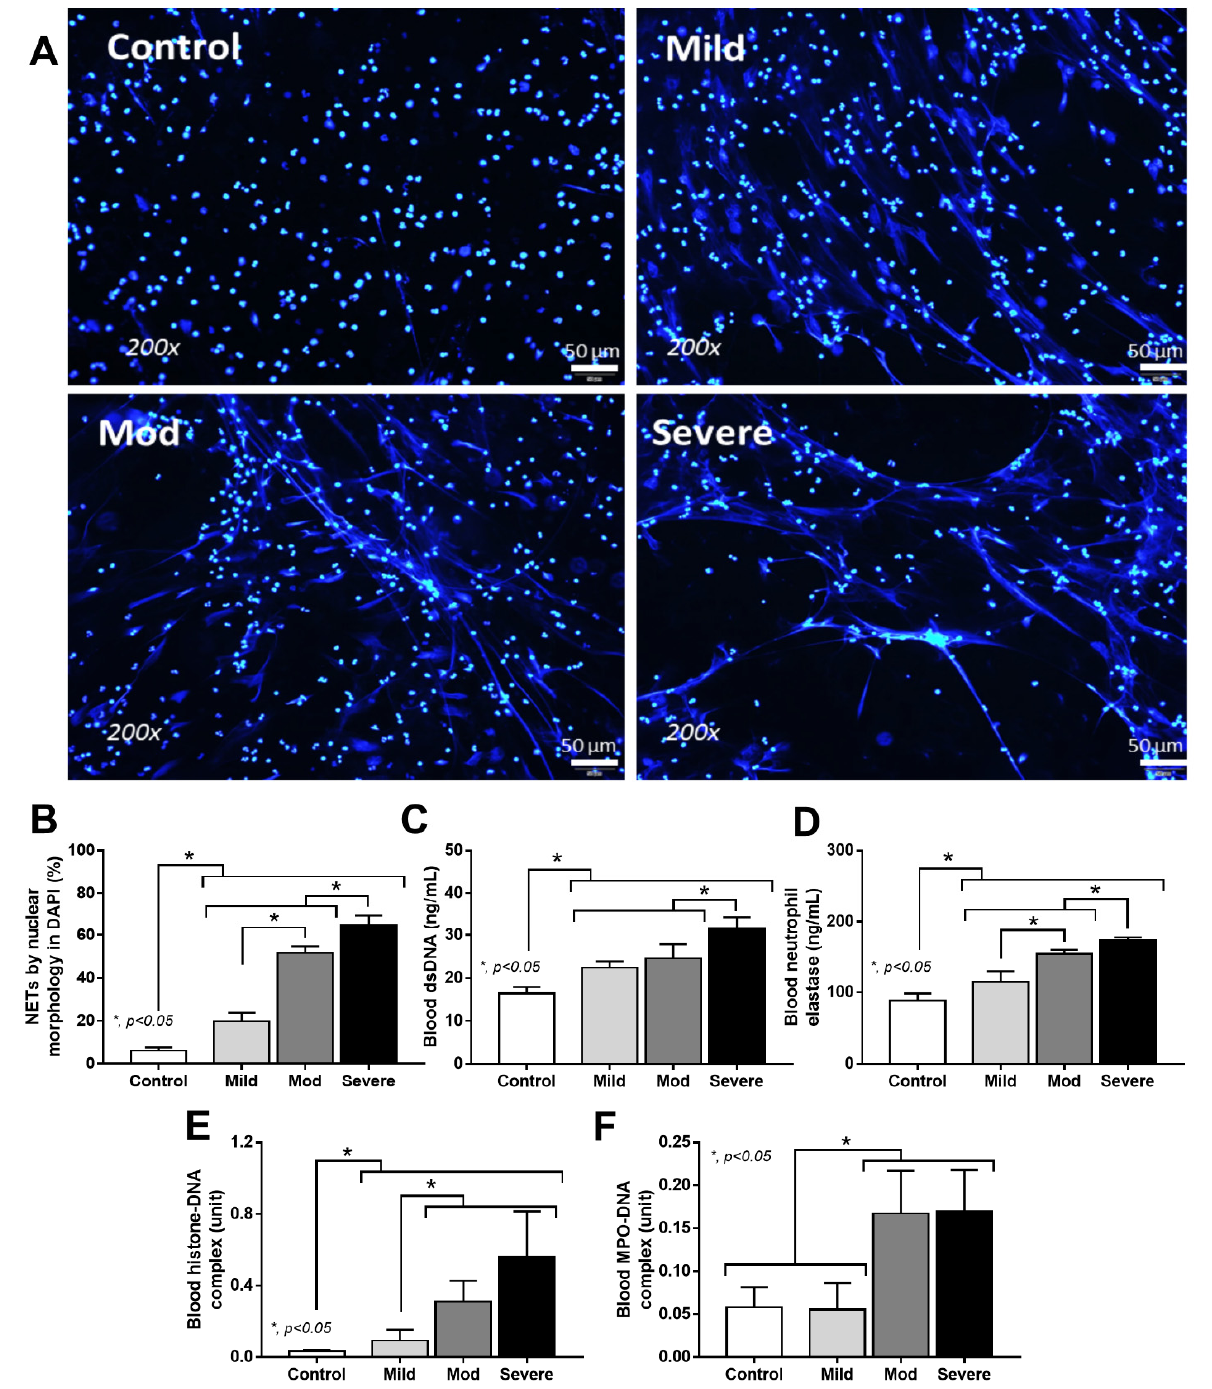
Figure 4. Neutrophil extracellular traps (NETs) of patients with COVID-19 in different severities— mild ( n = 27), moderate ( n = 28), and severe ( n = 20), versus healthy control ( n = 15), as indicated by morphology of DAPI nuclear staining with the representative pictures ( A , B ), blood dsDNA ( C ), blood neutrophil elastase ( D ), histone–DNA complex ( E ), and myeloperoxidase (MPO)–DNA complex ( F )—are demonstrated. * p < 0.05 between the indicated groups as determined by ANOVA with Tukey’s analysis.